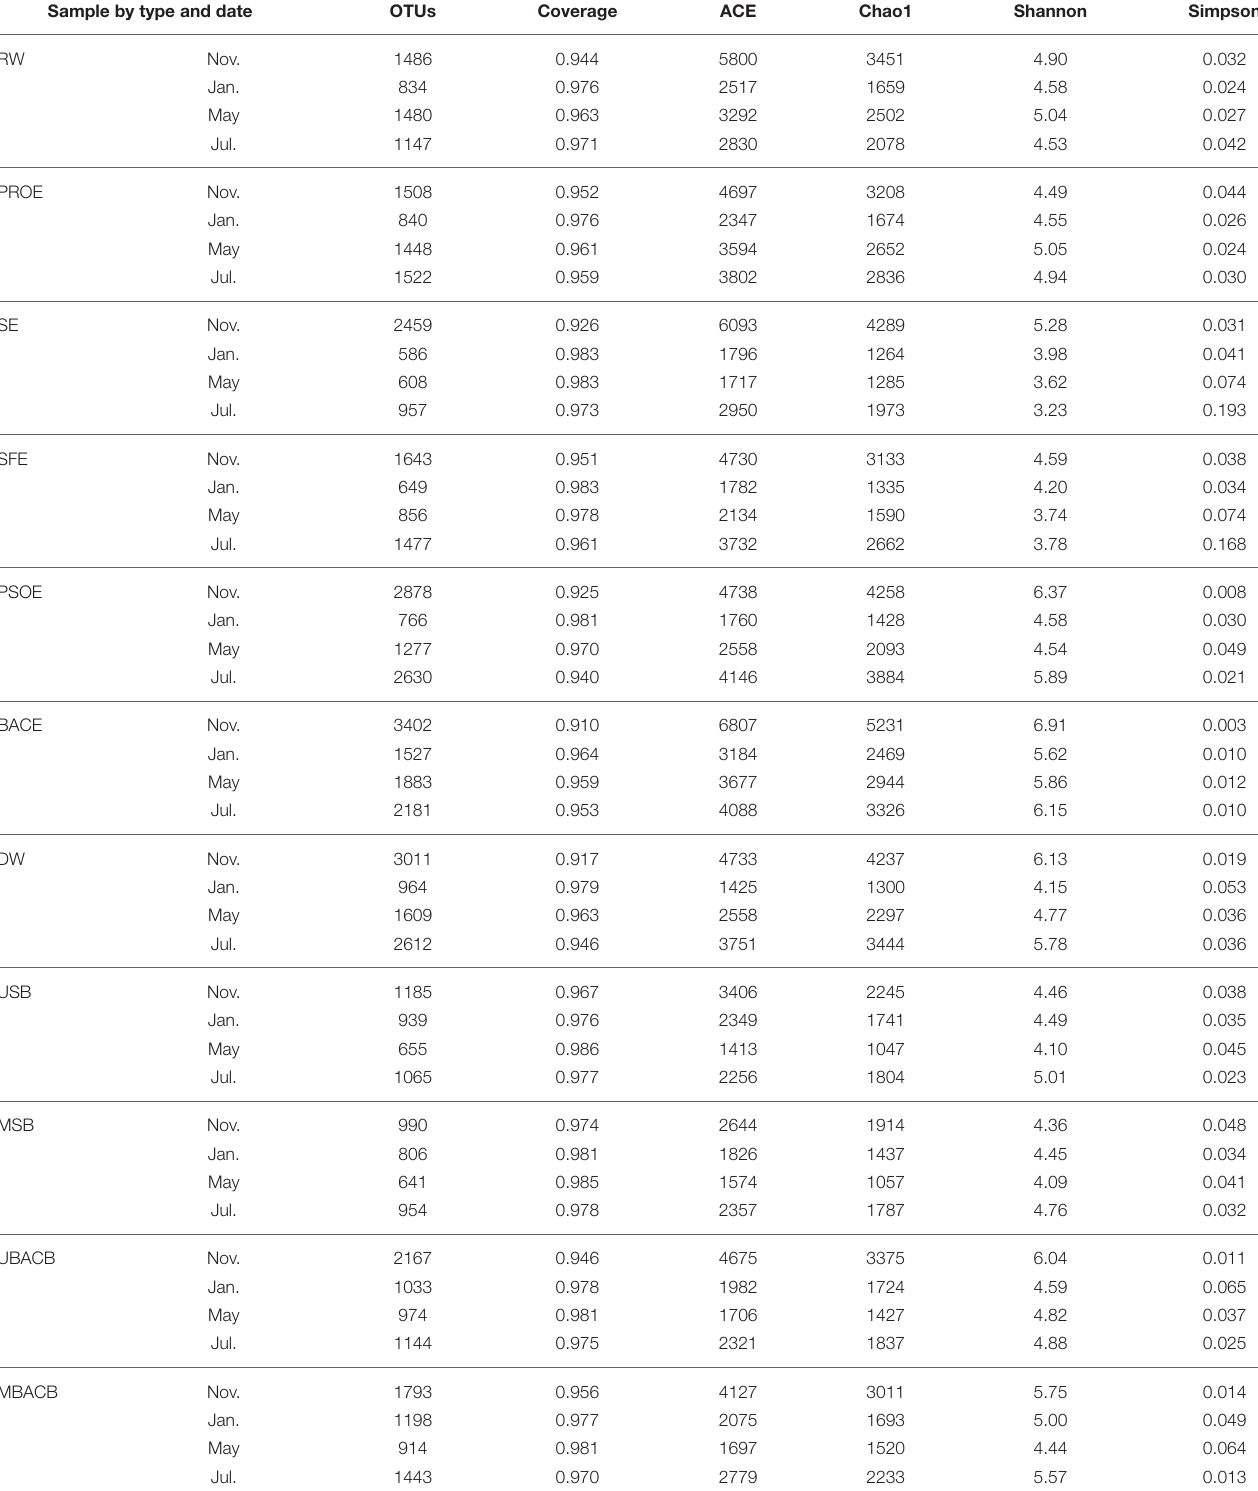
TABLE 2 | Bacterial community richness and diversity indices at each treatment step and the four sampling times. Sample by type and